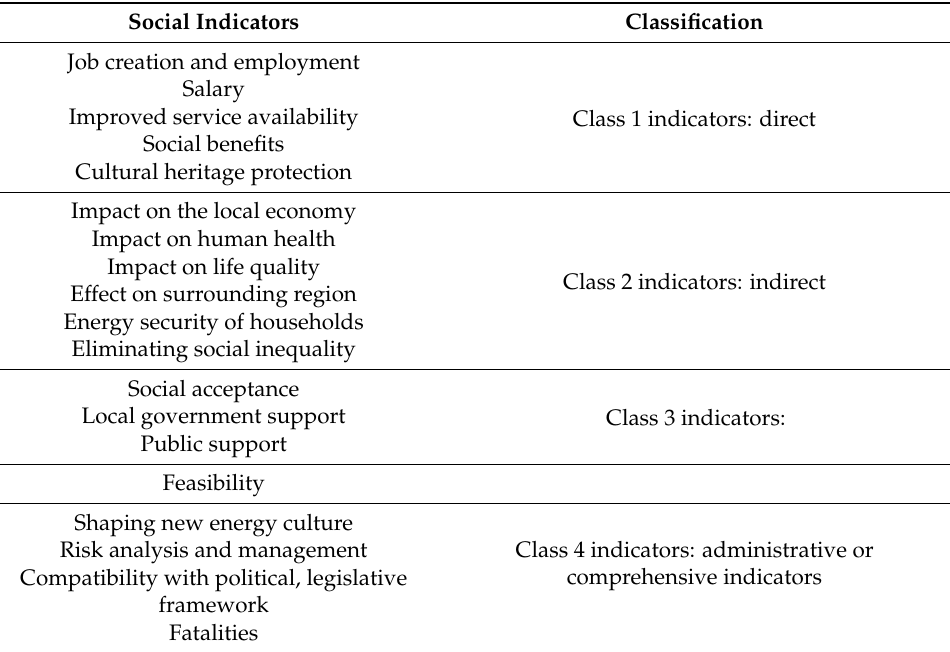
Table 4. The most commonly utilized social indicators.